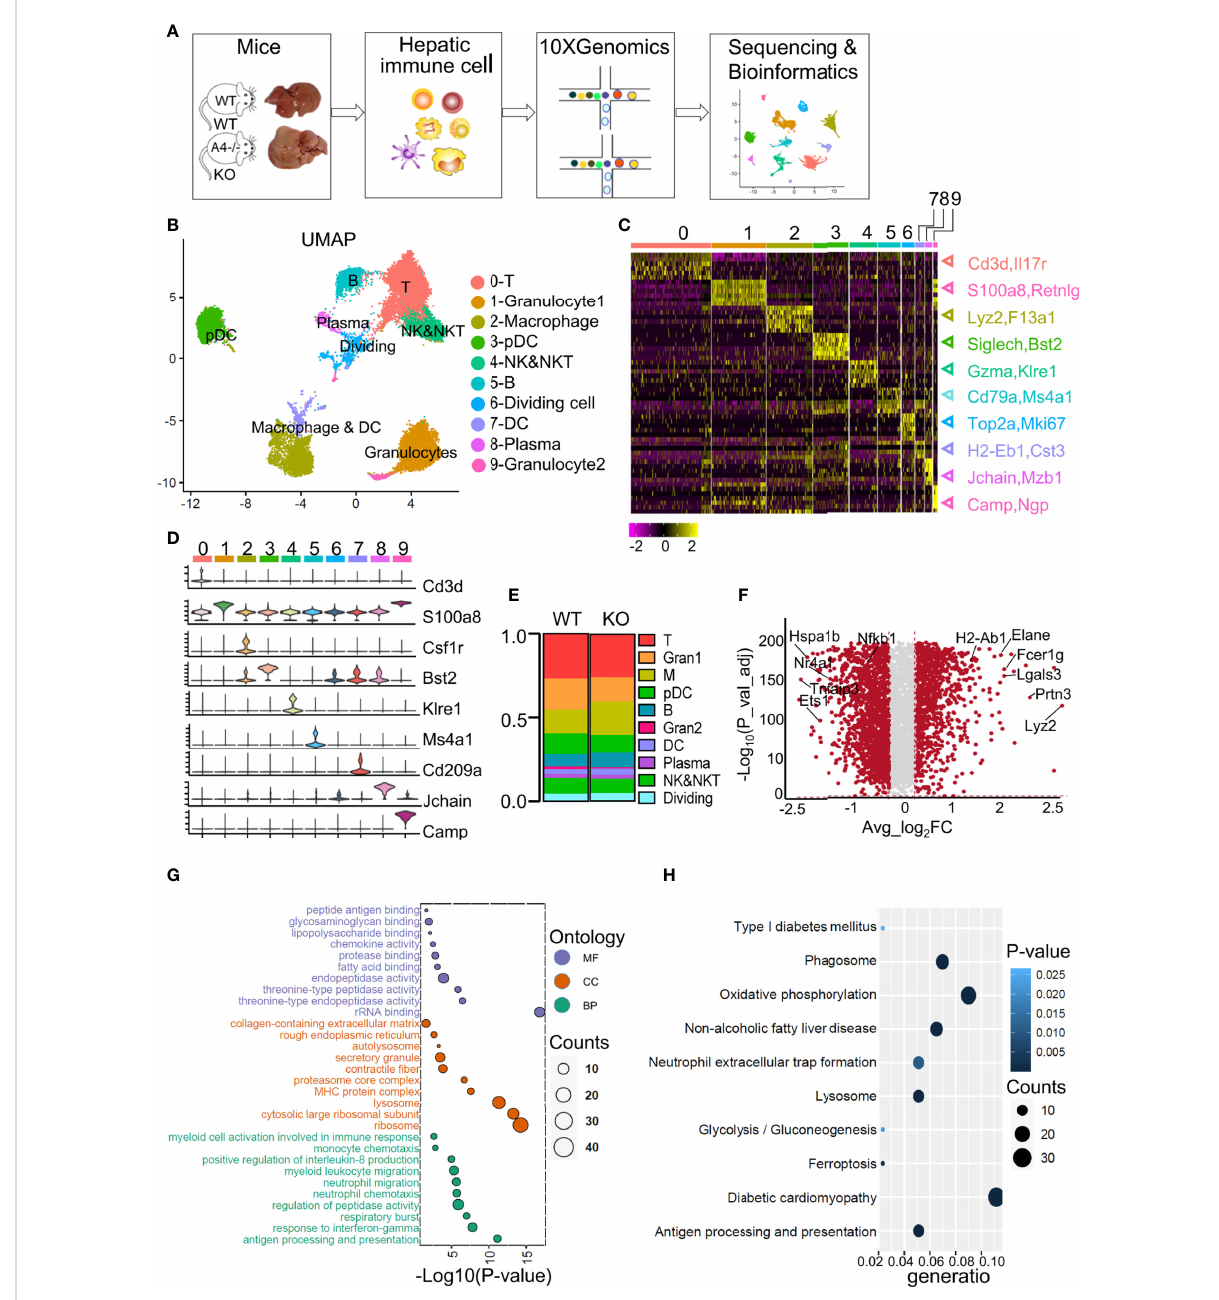
FIGURE 1 ScRNA-Seq pro fi les of liver immune cell populations and the differences between WT and ApoA4 KO mice. (A) Schematic diagram of hepatic immune cell isolation and data analysis using the 10X genomics platform. (B) UMAP visualization of hepatic immune cells showing 10 clusters. (C) Heatmap of the 6 most strongly upregulated genes in each cluster (genes were decreased by P value ). (D) Violin plots showing speci fi c marker expression in each cluster. (E) The proportion of each type of immune cell in the WT and KO groups is shown in (B) . (F) Volcano plot showing differentially expressed genes (DEGs) between WT and KO mice. Average_log 2 fold change > 0.2 & -log 10 ( P value-adjust) > 2 are red; others are grey. (G) Gene Ontology (GO) enrichment analysis of molecular function (MF), cellular component (CC), and biological process (BP) for the upregulated genes of KO mice vs. WT mice. (H) Kyoto Encyclopedia of Genes and Genomes (KEGG) analysis of upregulated genes in KO mice vs. WT